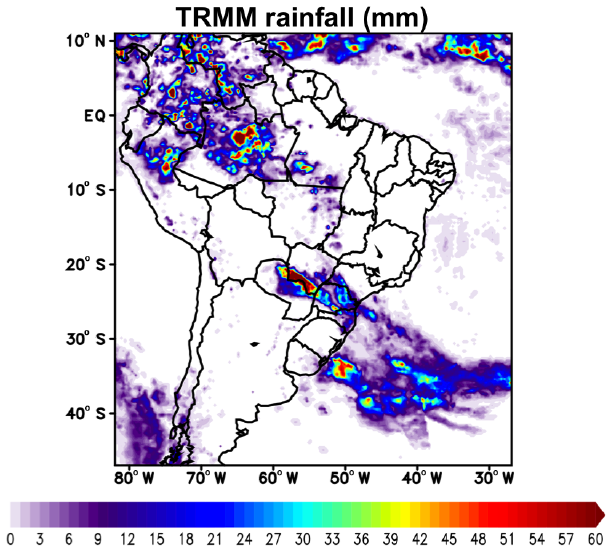
Figure 8. TRMM 24h accumulated rainfall for the day of 12 Oc- tober 2015. The data are produced at 0.25 ◦ grid resolution and the unit is